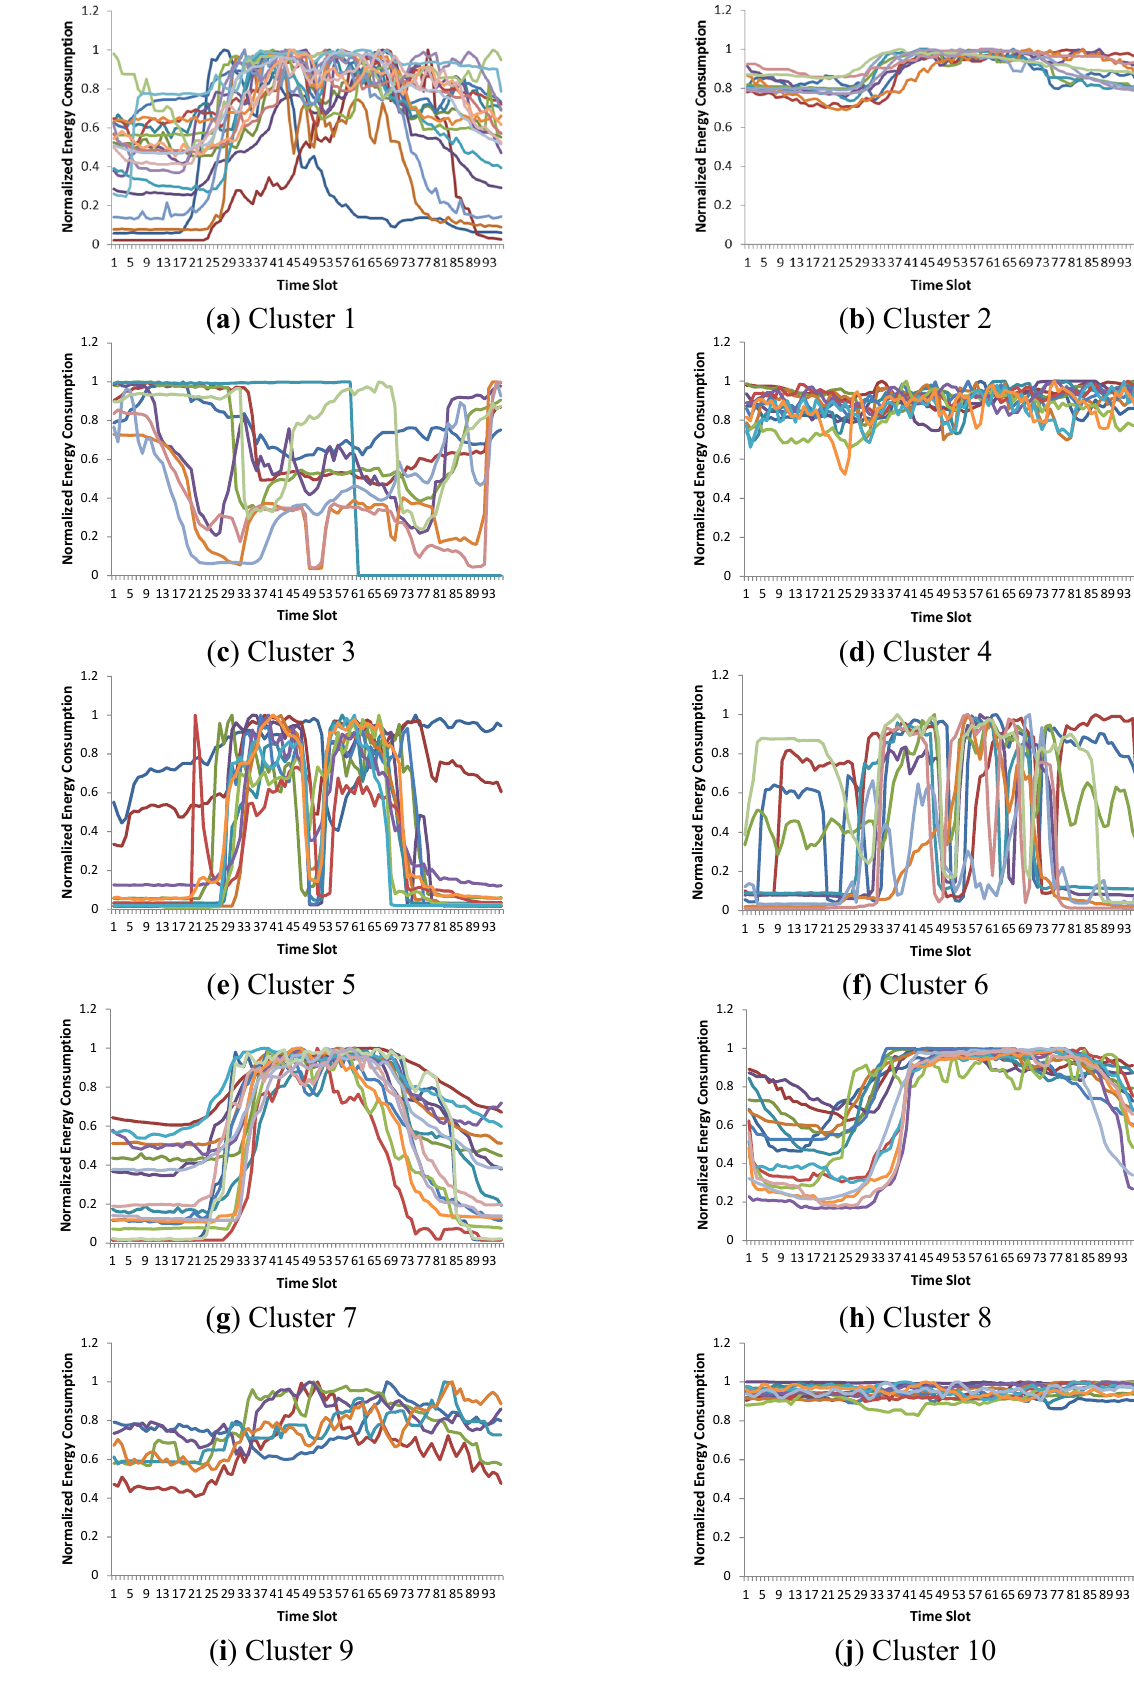
Figure 3. Clustering result by an expert with the data from southern part of Gyeonggi Province. ( a )–( j ) Clusters